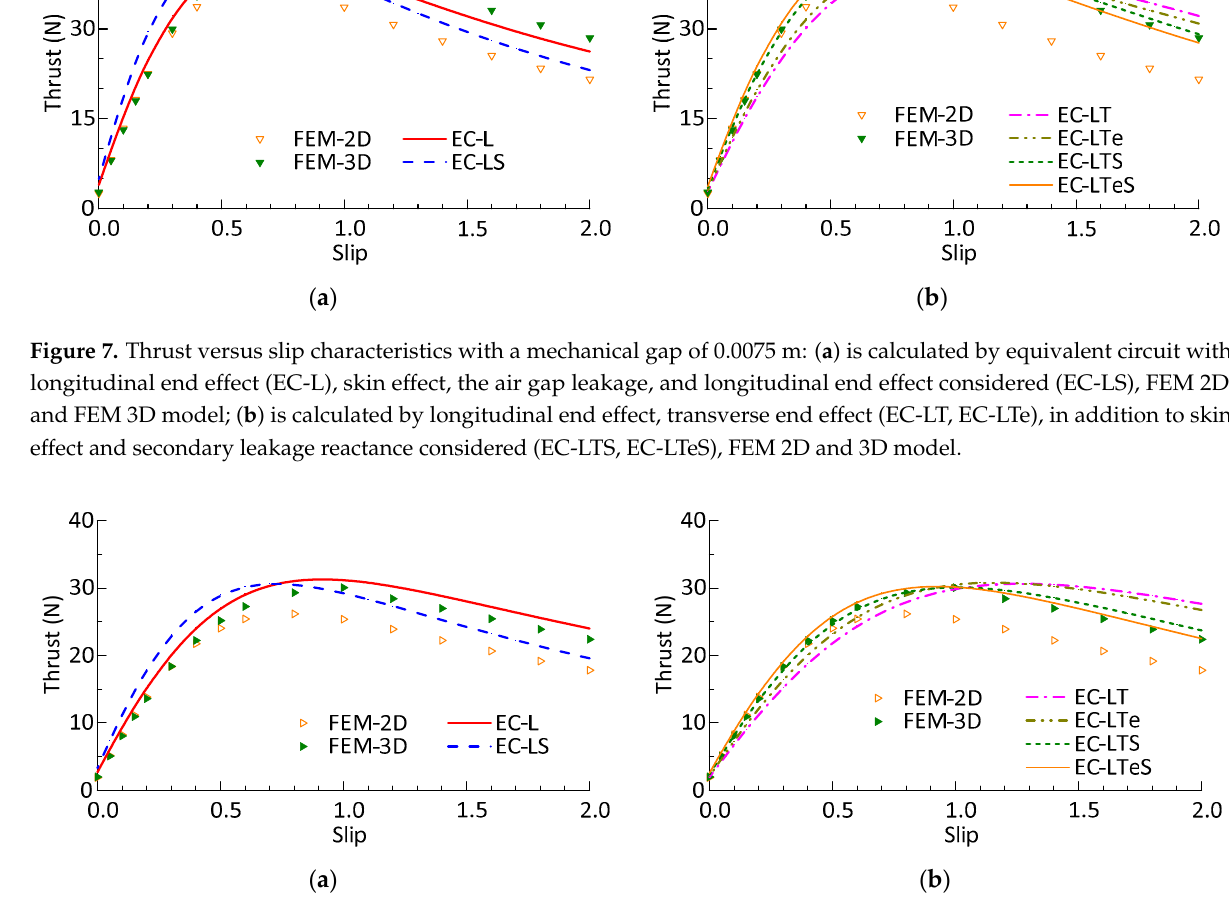
( b ) Figure 9. Thrust versus slip characteristics with a mechanical gap of 0.0135 m: ( a ) is calculated by equivalent circuit EC-L, EC-LS, FEM 2D, and FEM 3D model; ( b ) is calculated by equivalent circuit EC-LT, EC-LTe, EC-LTS, EC-LTeS, FEM 2D, and 3D model.